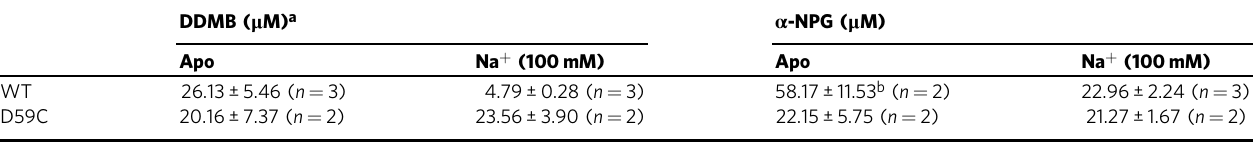
Table 2 IC 50 of galactoside displacement on bound D 2 G by MelB St